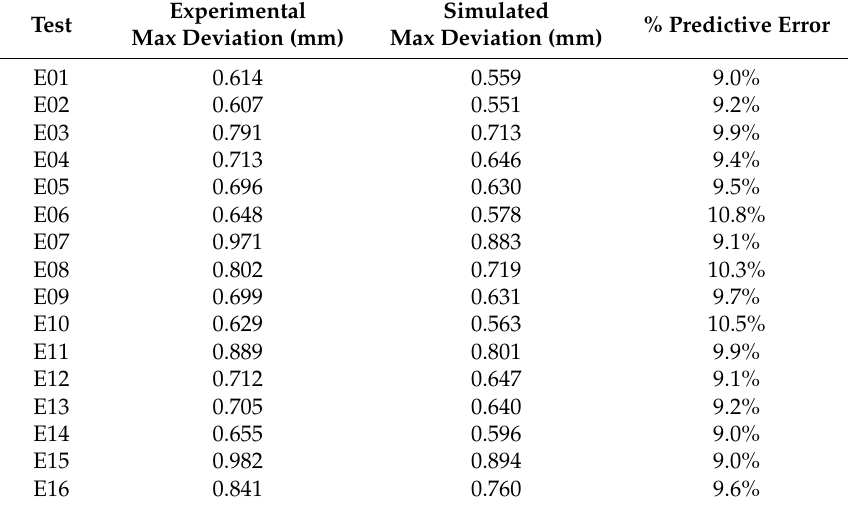
Figure 6. Test pieces machined in Al and PUR 300. Table 4. Simulated and experimental maximum cutting tool path deviation (SEMPAD) for